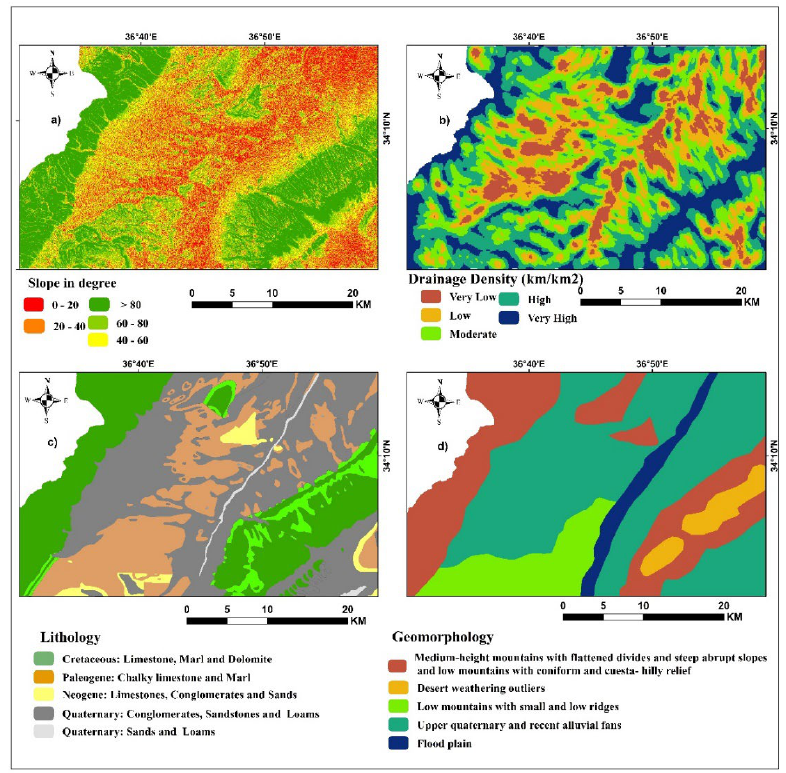
Figure 5. ( a ) Slope, ( b ) Drainage density, ( c ) Lithology, and ( d ) Geomorphology. Low groundwater recharge occurs in media with a high drainage density, and Rainfall is the primary source of recharge for aquifer units [38,44,97]. As a result, the possibility of GWPZs grows as rainfall distribution changes. The rainfall in the study area ranged from 111 to 430 mm (Figure 6a). The highest rainfall areas had a higher amount of GWPZ. The areas with 270 to 430 mm (19%) of rainfall areas were assigned high weight- age. The overall score of the rainfall factor ranged from 7 to 3 and 4 to 36 when calculated using the MIF and AHP method, respectively (Table 6).